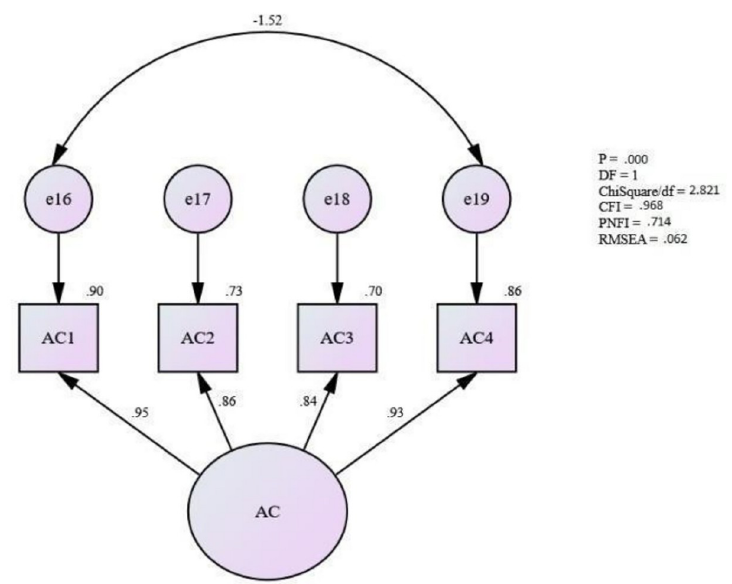
Fig 3. Measurement model for affective commitment.